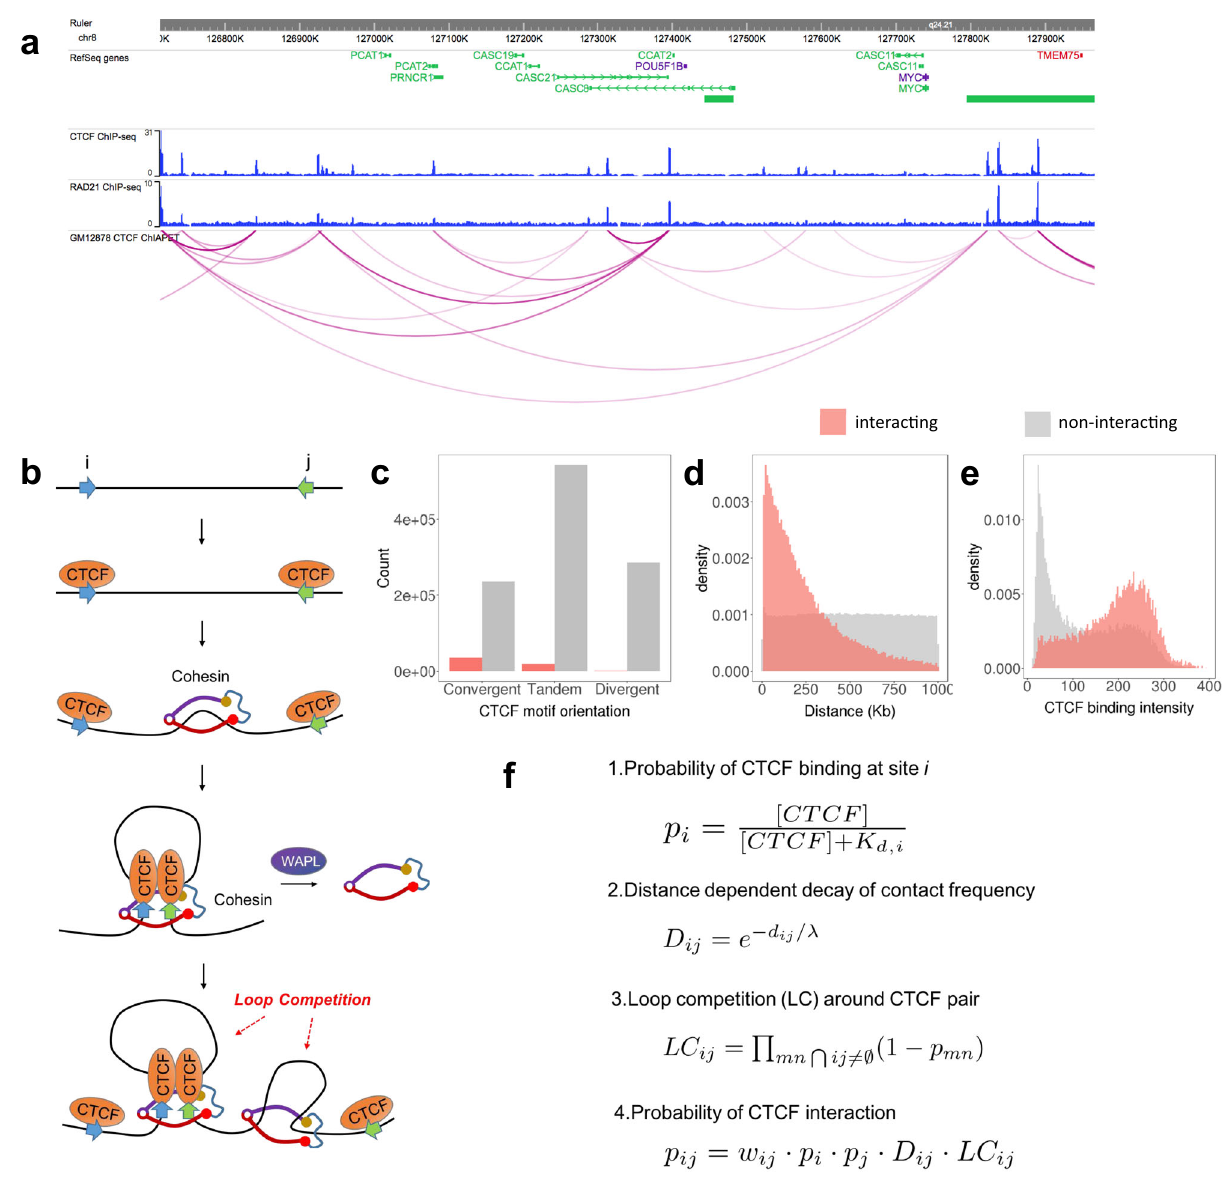
Fig. 1 Mathematical formulation of a loop competition and extrusion model. a We use CTCF ChIA-PET to train our model: the contact pro fi le of the Myc locus in GM12878 is shown. b Loop extrusion model: Cohesin is loaded between (typically convergent) CTCF pairs, and the loop forms progressively as Cohesin translocates along the chromatin fi ber. The extrusion process stops when Cohesin is stalled by CTCF. WAPL unloads Cohesin from chromatin. An existing loop could block movement of another Cohesin protein, leading to loop competition. c While measured loops prefer convergent CTCF pairs, other orientations also interact with signi fi cant frequencies and many neighboring (<1 Mb) convergent CTCF motifs do not form loops: shown are interacting pair counts (red), and non-interacting pair counts (grey). Here interacting and non-interacting loops are de fi ned by ChIA-PET interaction data. d Distance distribution for interacting and non-interacting CTCF pairs. e CTCF binding intensity distribution for interaction and non-interaction CTCF pairs. f Mathematical model of loop interaction probability formed by this extrusion